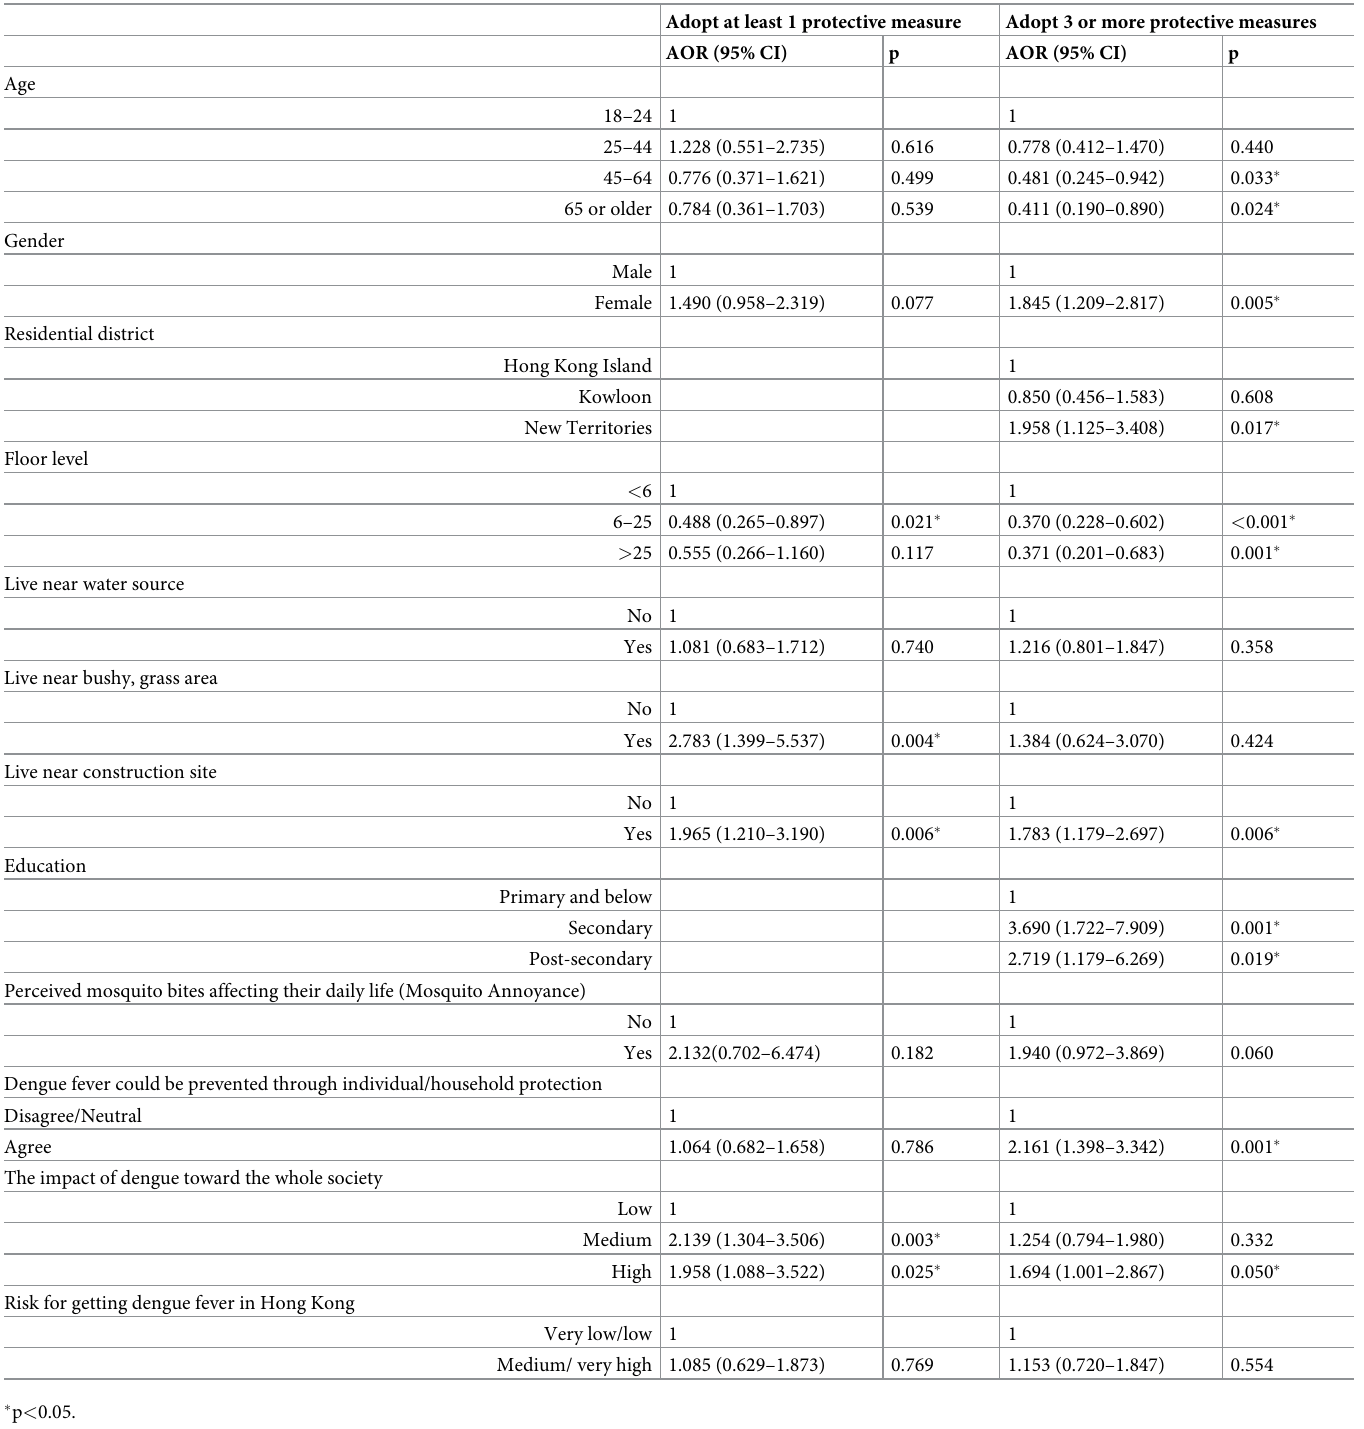
Table 5. Associated factors of the use of protective measures against mosquito